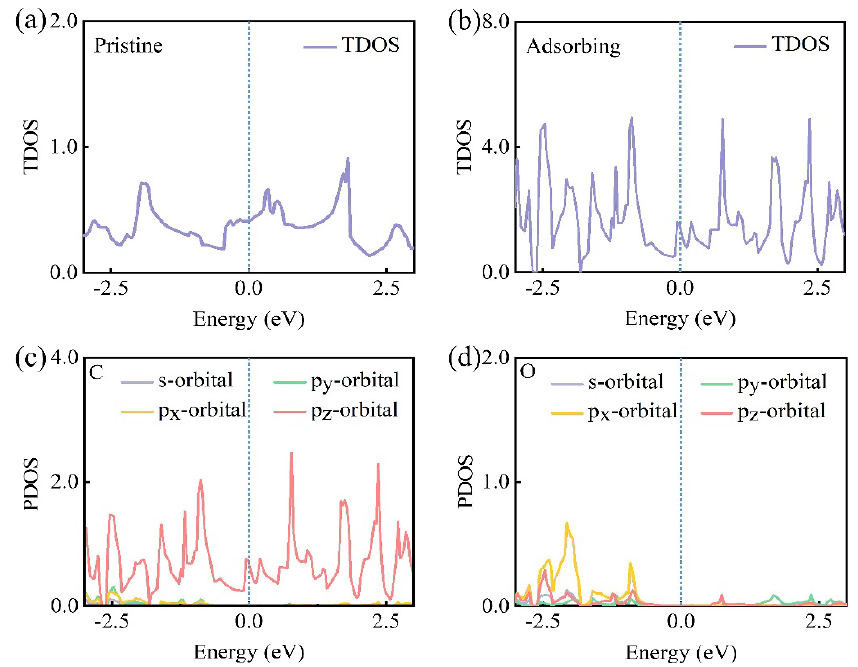
Figure 5. Electronic properties of ( a ) pristine structure and ( b – d ) adsorption structures. The TDOS of ( a ) pristine biphenylene and ( d ) adsorbing biphenylene. The PDOS of ( c ) C and ( d ) O.